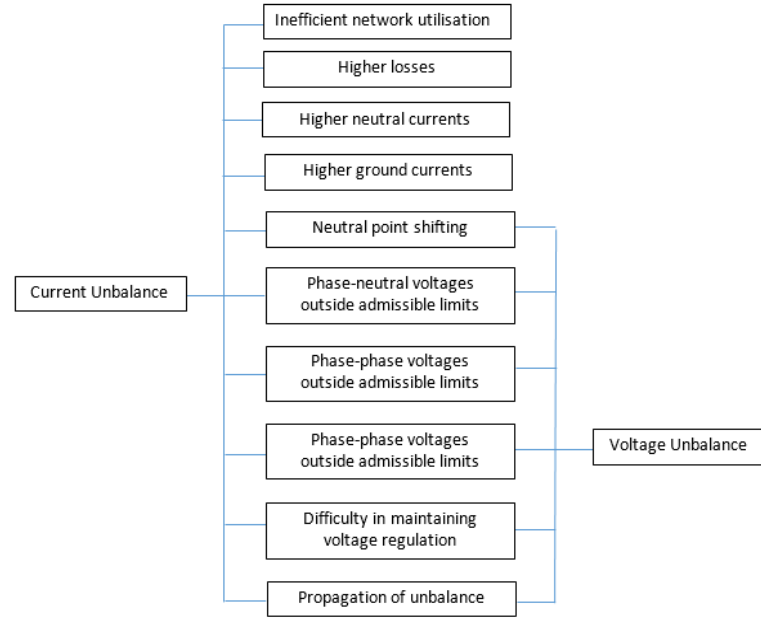
Figure 1. The issues caused by the current unbalances [3] .